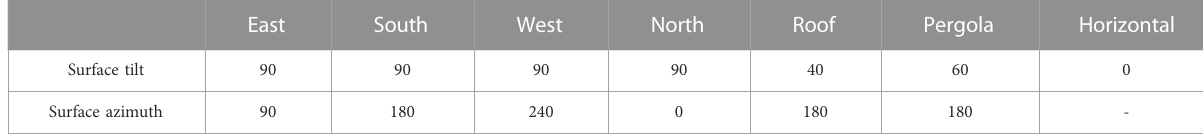
TABLE 2 Orientation of the pyranometers installed in the ZEB Laboratory.